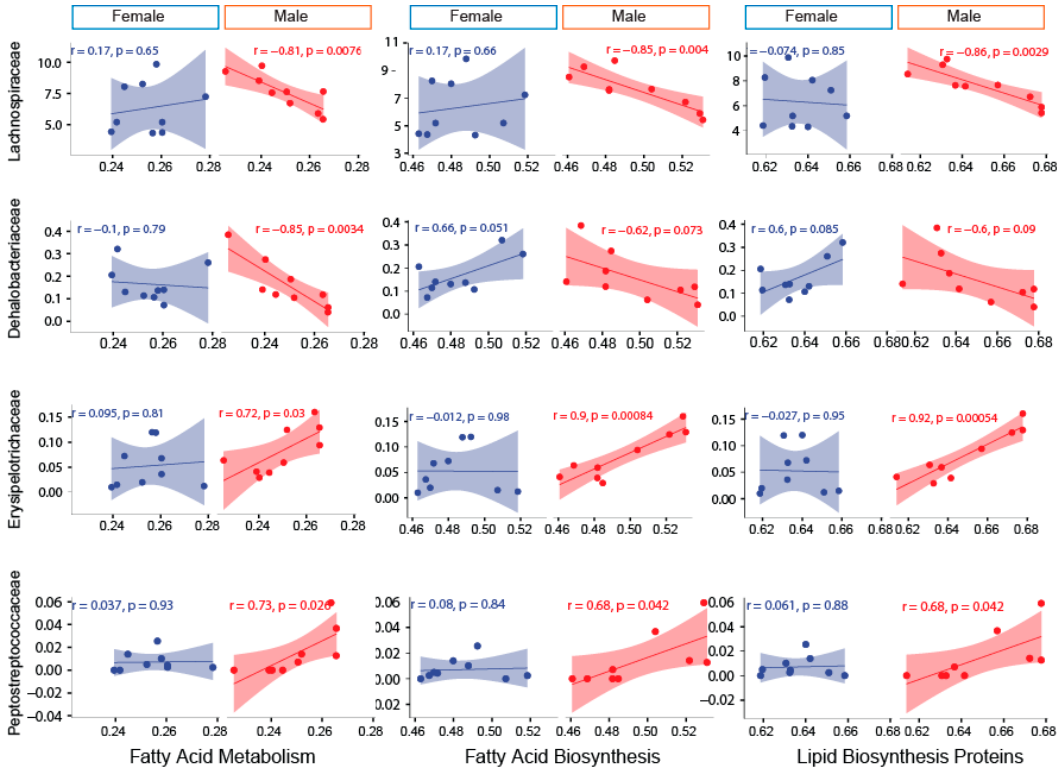
Figure 6. Spearman correlations of specific metabolic pathways predicted from microbial genomes, with the operational taxonomical unit (OTU) abundance of families. Pathways such as lipid metabolism, fatty acid metabolism, lipid biosynthesis, etc. and their association with OTU abundances at family-level taxa are shown. The color red denotes a positive association, whereas the color blue denotes negative correlations; only statistically significant correlations are depicted. The color gradient represents the degree of association.